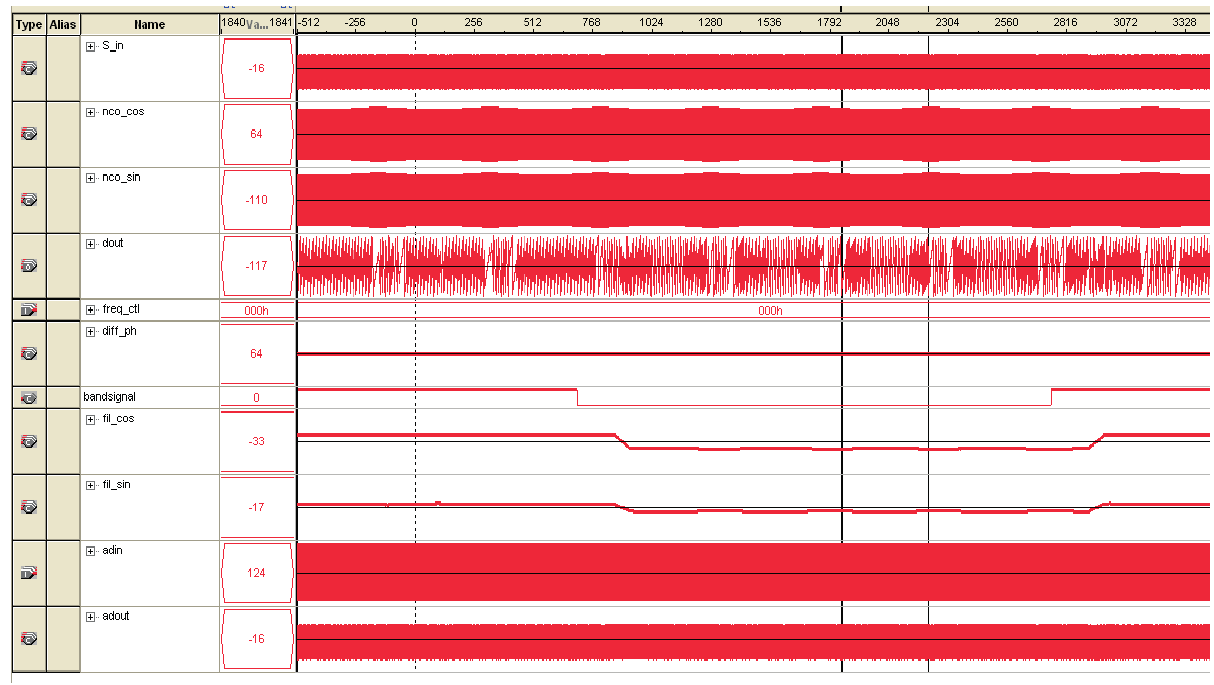
Figure 26. The waveform of carrier loop